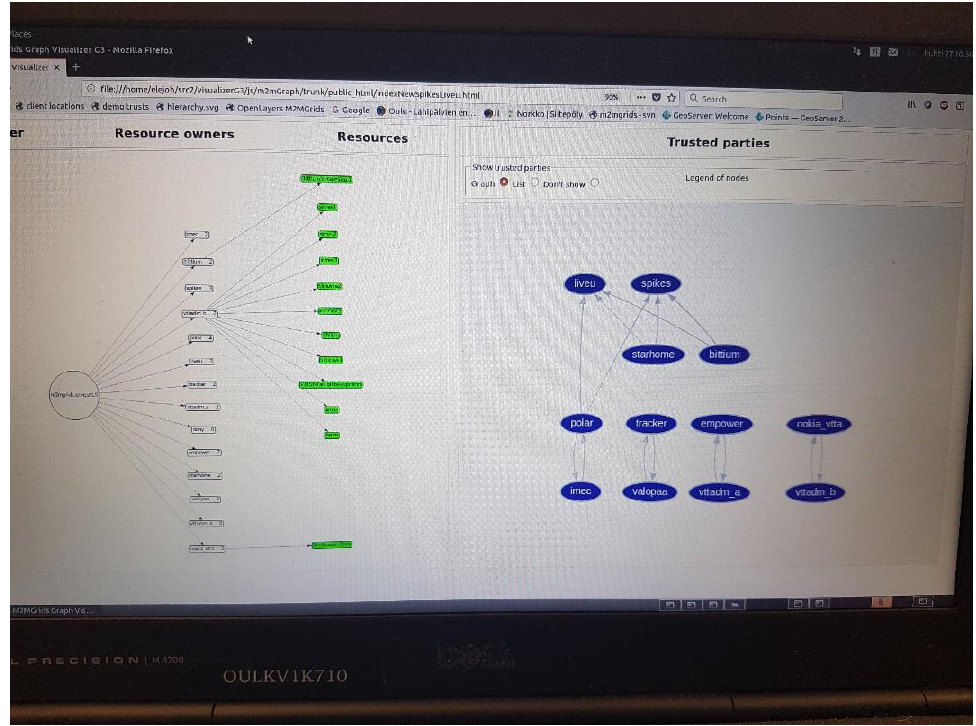
Figure 29. Trust relationship between the owners after the alarm event, the traffic accident, has happened. The visualization screenshot shows that after the alarm event has happened, the trust relationships between the owners are updated according to their policies. Finally, the information from the heart rate measured via the Polar smart watch, the video picture captured by Starhome camera, the CO 2 level measured by IMEC sensor, and the entropy stream extracted relying on the information published by Ekg / Egg sensor of Bittium can be seen in the screen provided for the authorities from the tra ffi c accident area after the alarm has happened; Figure 30.